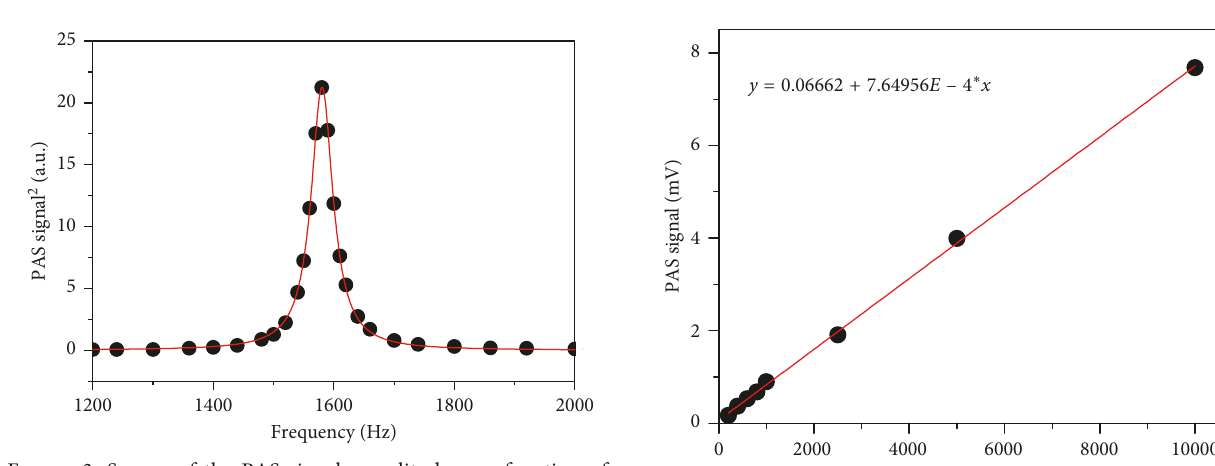
Figure 3: Square of the PAS signals amplitude as a function of frequency. The data are fitted with a Lorentz profile.